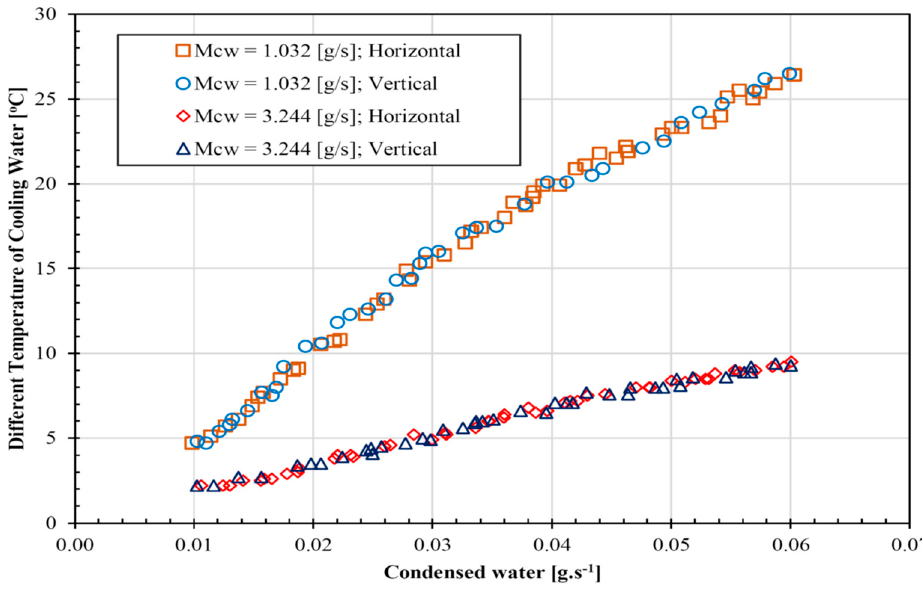
Figure 7. The effect of different temperatures of cooling water on the condensed water flow rate. Figure 7. The e ff ect of di ff erent temperatures of cooling water on the condensed water flow rate.